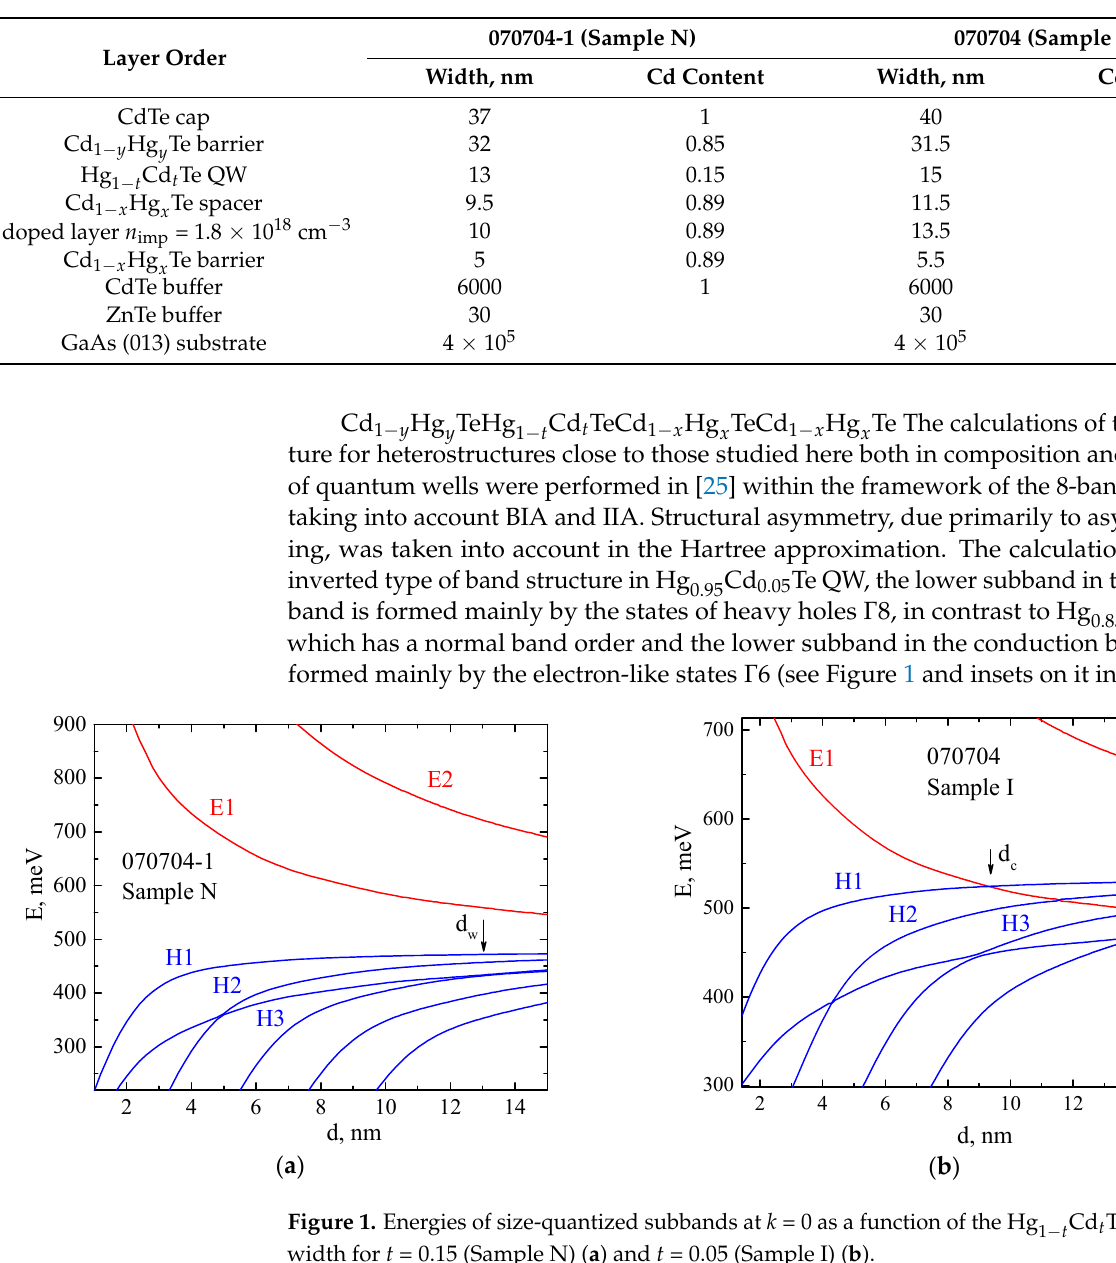
Table 1. Structural parameters of the samples under study.